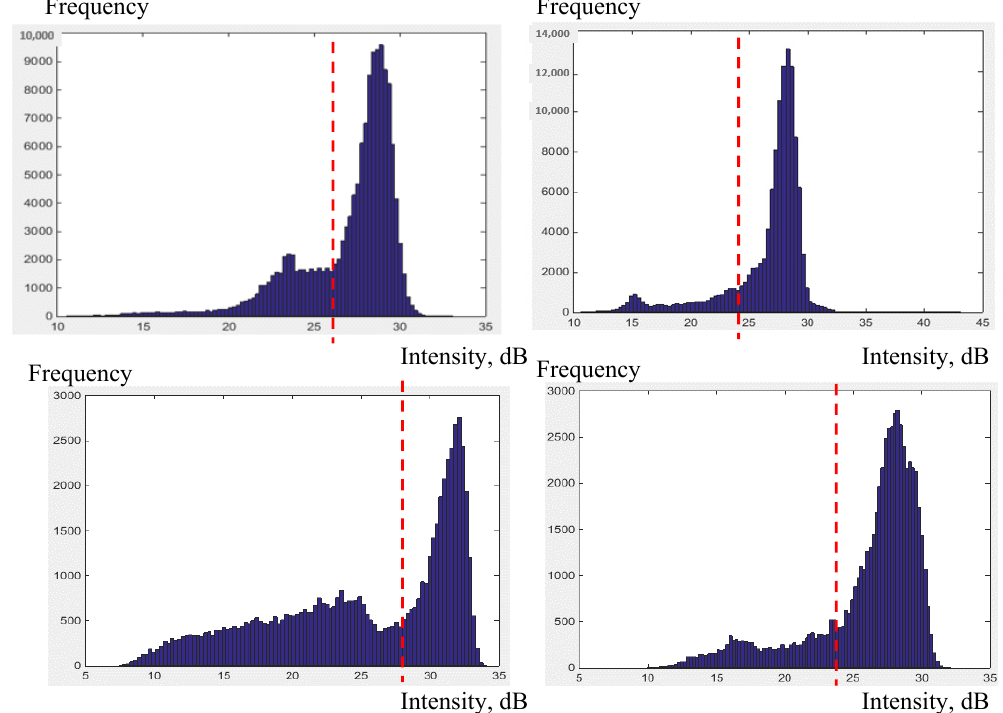
Figure 5. Manually define threshold for the histogram of intensity values differentiating point clouds of branches and leaves.